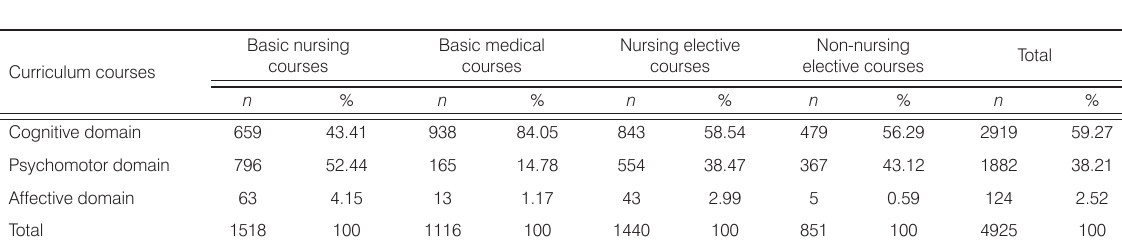
Table 2. The classification of learning outcomes.